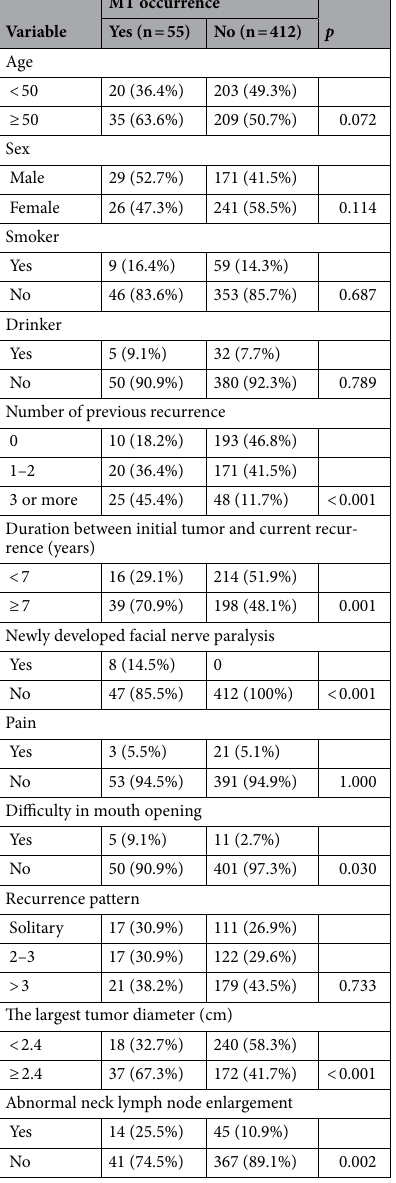
Table 1. Univariate analysis of the association between preoperative data and malignant transformation (MT)